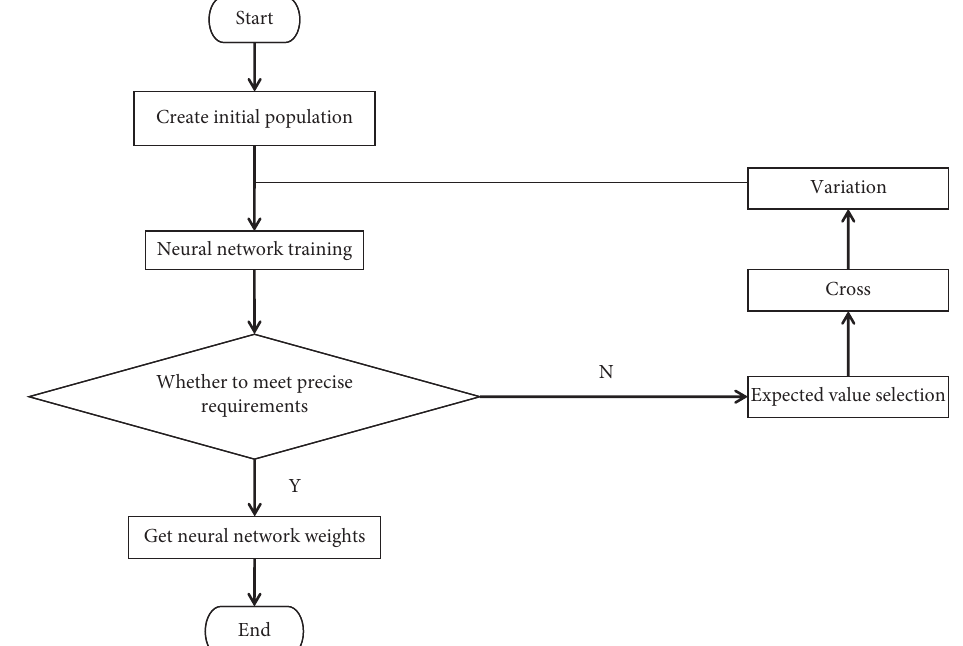
Figure 19: Flow chart of genetic algorithm of optimized neural network weights.